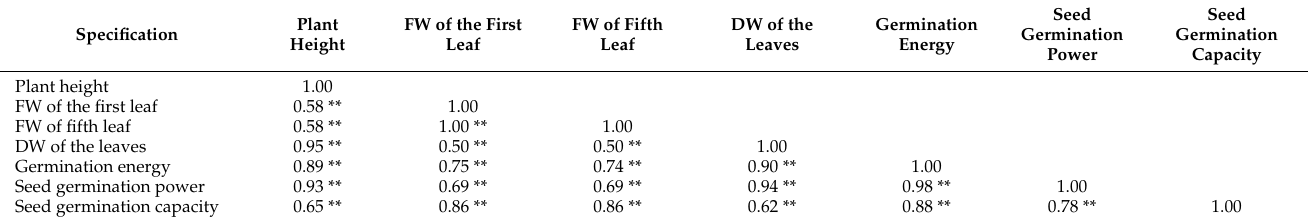
Table 5. Simple correlation coefficients of morphological and physiological features of common